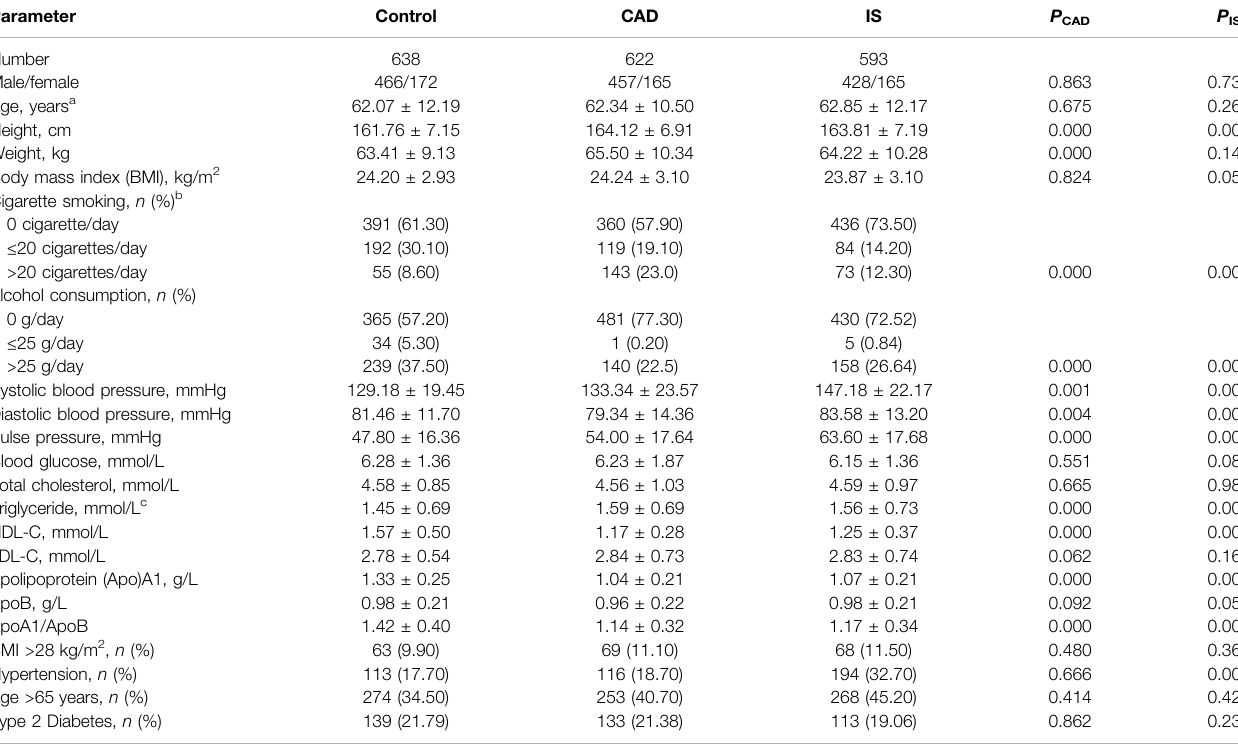
TABLE 1 | General and biochemical characteristics of the participants. Parameter Control CAD IS P